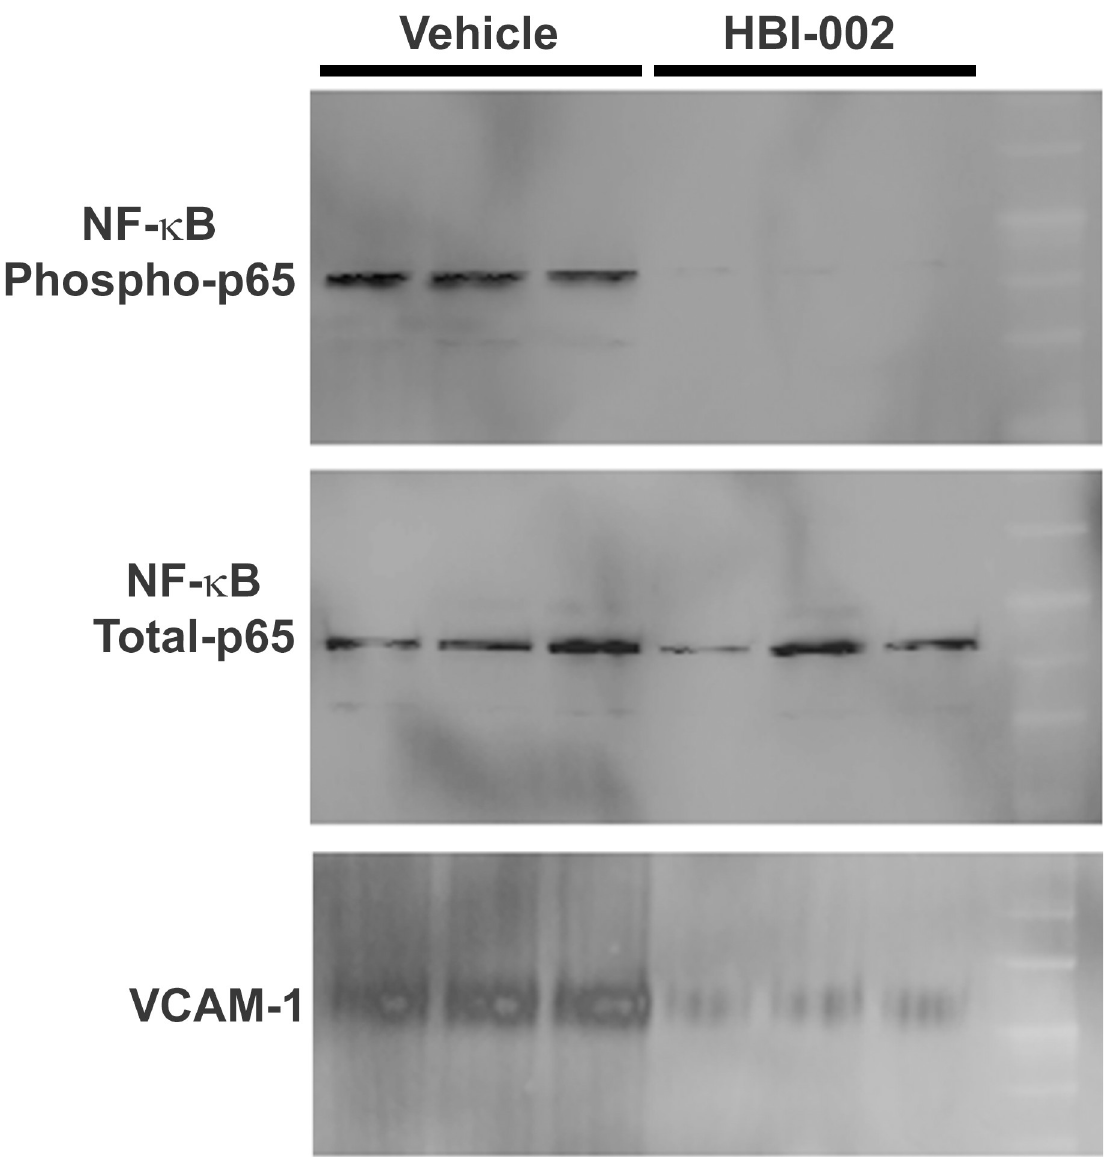
Fig 4. HBI-002 decreases hepatic NF- κ B activation and VCAM-1 expression. Townes-SS mice (n = 3/group) were gavaged once-daily with HBI-002 or vehicle (10 ml/kg). On day 10 of treatment the livers were removed and frozen. NF- κ B phospho-p65 and VCAM-1 expression was examined on immunoblots of hepatic nuclear extracts and microsomes,